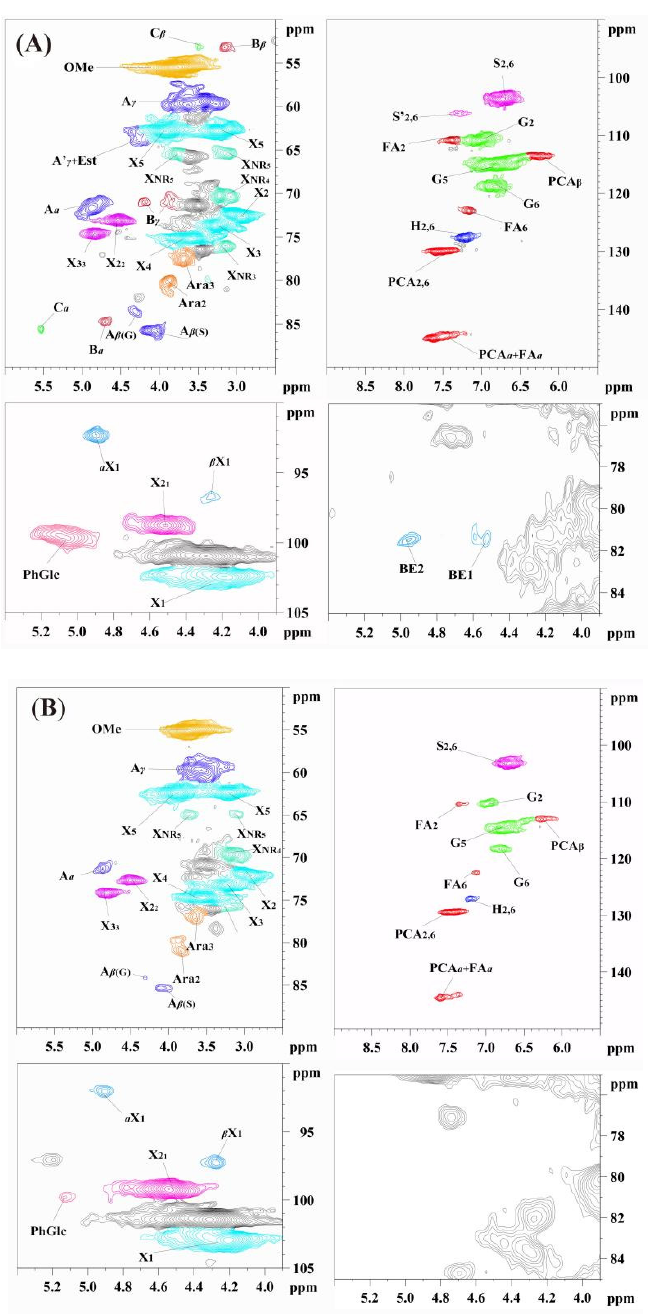
Figure 1. 2D-HSQC NMR spectra of LCC-WS-A ( A ) and LCC-WS-B ( B ) . To analyze changes in the substructures and linkages of LCCs, 13C-NMR and 2D HSQC NMR were combined and used to quantify their amounts (per 100 Ar (C900)) (Sup- plementary Figure S1). As shown in Table 2, LCC-WS-A contained the highest amount of each substructure (21.9/100 Ar of β - O -4, 5.5/100 Ar of β - β , and 2.3/100 Ar of β -5). Mean- while, LCC-WS-B contained only 14.1/100 Ar of β - O -4. Following the hydrothermal treat- ment of LCC-WS-A, the S:G ratio increased from 0.8 to 1.9. Table 2. Amounts (semi-quantitative data) of lignin substructures and lignin-carbohydrate linkages in LCC-WS-A and LCC-WS-B (per 100 Ar). Characteristics